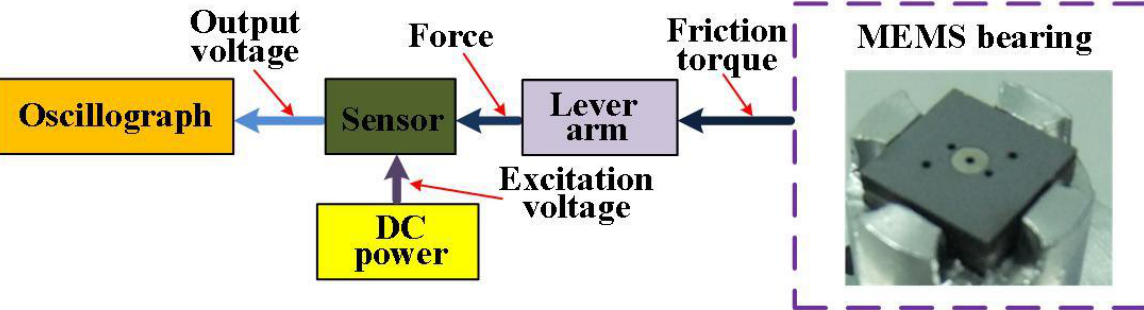
Figure 1. The schematic diagram of the measurement system for friction